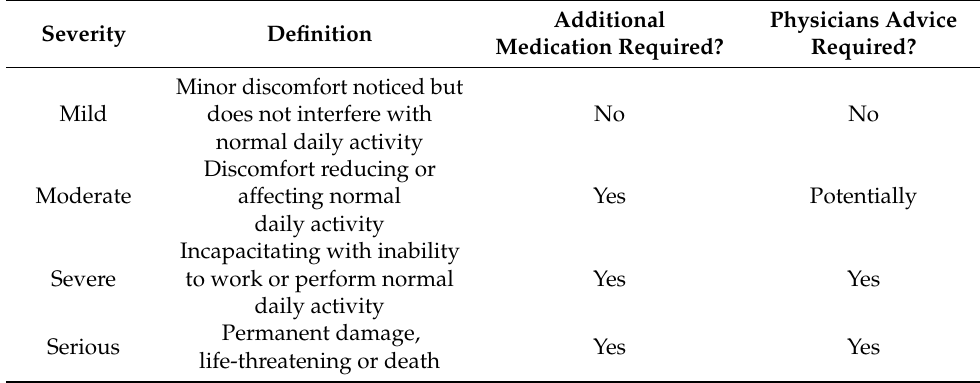
Figure 1. The OMERACT-OARSI criteria to define responding and non-responding subjects to treatment interventions in knee osteoarthritis. The therapeutic response rate (TRR%) is derived from this classification at respective follow-up timepoints after MFAT administration. Table 1. Definitions of adverse event (AE) severity with required interventions.